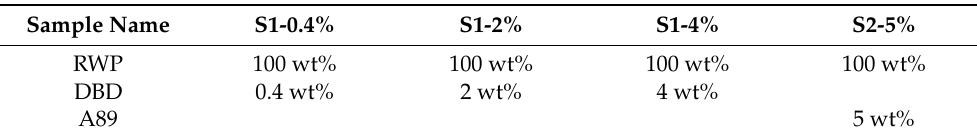
Table 4. Formulation of dry blends consisting of rubber waste particles (RWP) mixed with different amounts and types of devulcanizing agents.